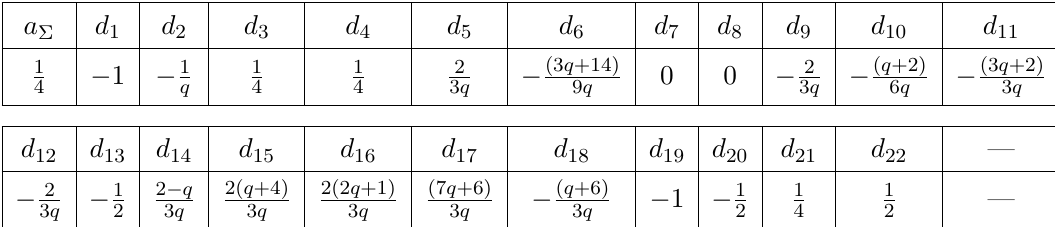
Table 1 . Defect central charges of a p = 4 defect holographically dual to an AdS 5 probe brane